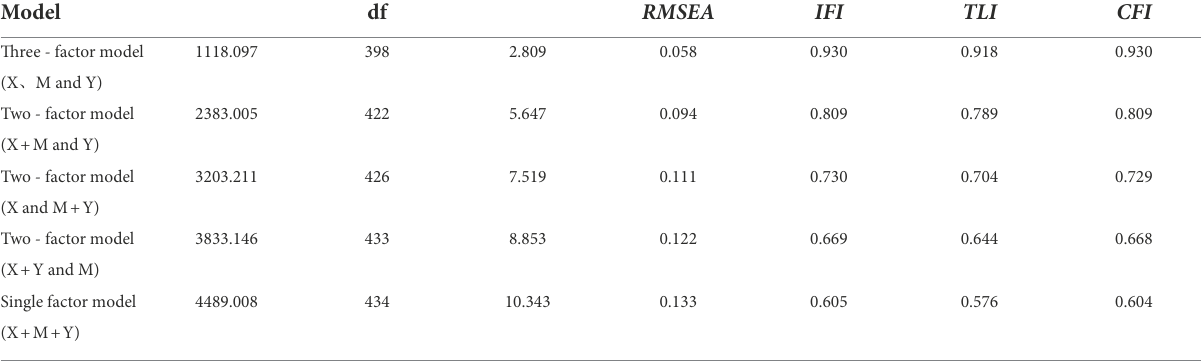
TABLE 2 Confirmatory factor analysis results.